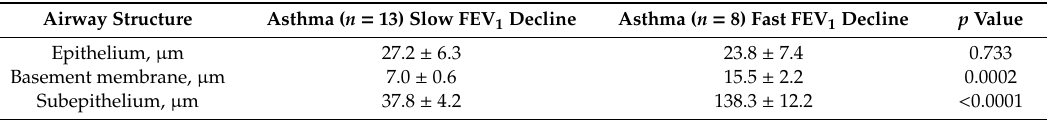
Table 3. The thickness of airway structure in patients with asthma.